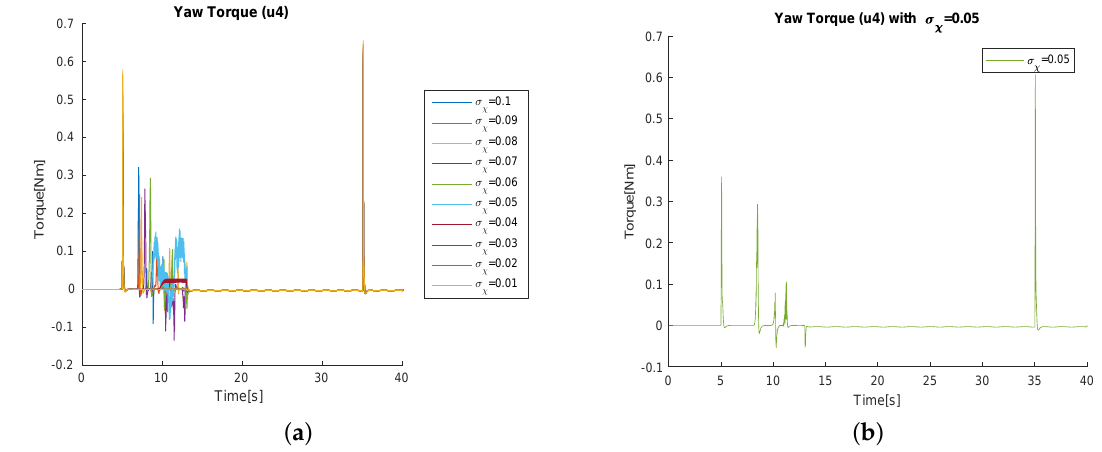
Figure 26. ( a ) Yaw Torque with distinct σ χ ’s; ( b ) Yaw Torque with σ χ =